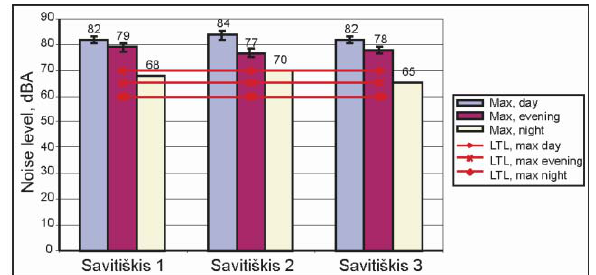
Fig. 13. Dynamics of maximum noise levels in Savitiškis street within twenty four hours